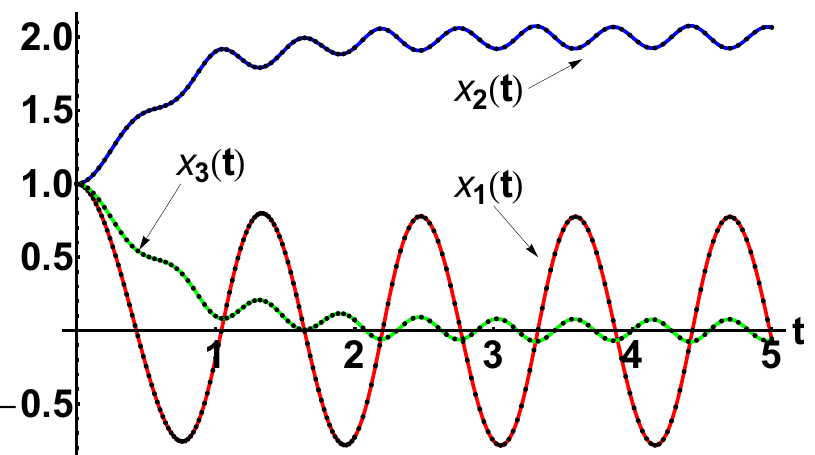
Figure 3: Profiles of the functions ¯ x 1 , ¯ x 2 , and ¯ x 3 respectively, given by Eqs. (22), (24), (26) on [0, 2] and Eqs. (23), (25), (27) on [2, 5] respectively: − − − − − numerical solution, · · · · · · · · · · · MOHAM solution.